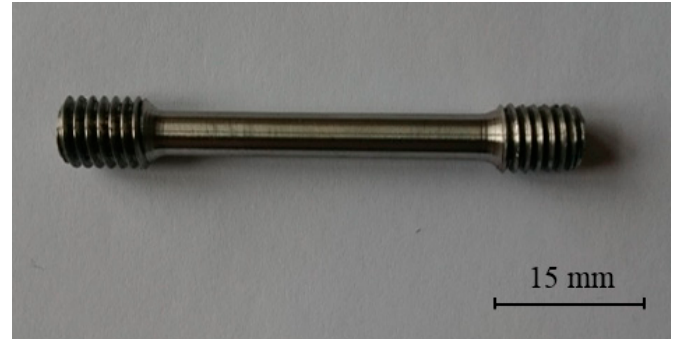
Figure 1. Tensile test specimen used for hot tensile testing.